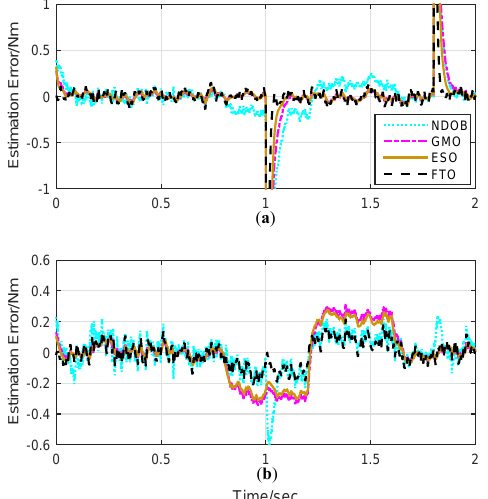
Figure 4. The disturbance estimation errors of external torque. ( a ) External disturbance estimation errors for joint 1; ( b ) external disturbance estimation errors for joint